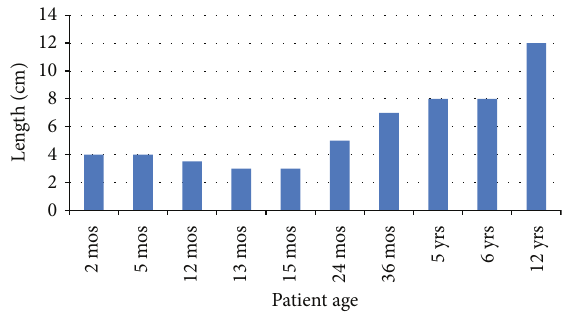
Figure 1: Length of involved skin relative to patient